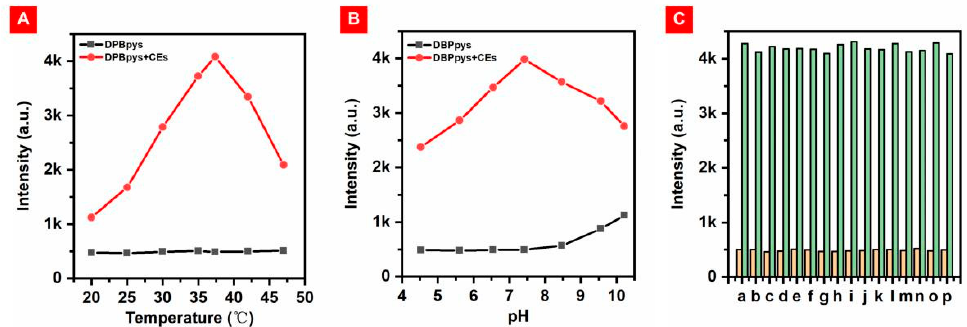
Figure 3. ( A ) Fluorescence intensity at 720 nm of DBPpys (10 μ M) with (red point) and without (black point) CEs in DMF : HEPES ( v:v = 4 : 6) at different temperatures. ( B ) Fluorescence intensity of DBPpys (10 μ M) at 720 nm with (red point) and without (black point) CEs in DMF : HEPES ( v:v = 4 : 6) with different pH values. ( C ) Fluorescence intensity of DBPpys (10 μ M) at 720 nm before (orange columns) and after (green columns) reaction with CEs in the presence of 200 μ M of various interfering substances in DMF : HEPES ( v:v = 4 : 6, pH = 7.4) at 37.4 °C. a: blank; b: Na 2 CO 3 ; c: Na 2 SO 4 ; d: KCl; e: H 2 O 2 ; f: ClO − ; g: Hcy; h: Cys; i: GSH; j: ADP; k: ATP; l: BSA; m: LAP; n: HSA; o: AFP; p: APN.